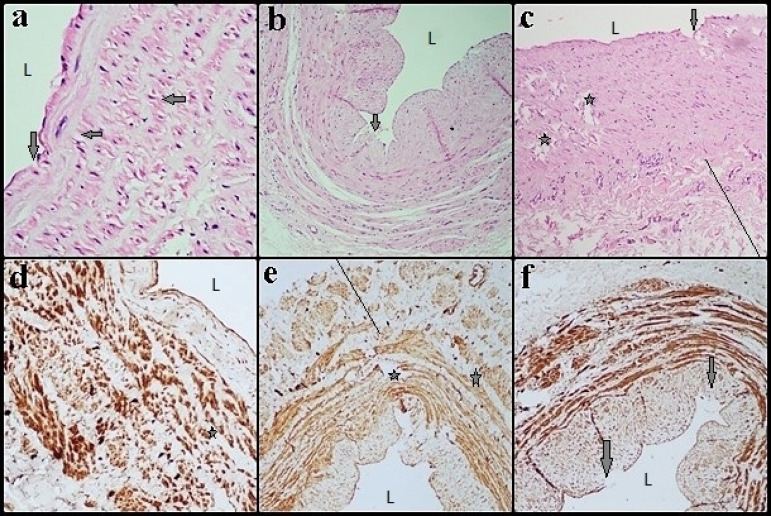
Group II (diabetes mellitus + coronary artery disease): vein sections stained with hematoxylin-eosin (a, b, and c) and parts stained for immunoreactivity with urotensin-II (d, e, and f). (a, b, c, and f) Endothelial areas are visible with lower arrows, internal elastic lamina lost its regular structure, and ruptures occurred in some regions. (d, e, and f) The vascular smooth muscle cells in the tunica media layer could not maintain its normal structure, there were changes in cell morphology and localization in many areas, and there were significant separations in the layer. Left arrows point to foam cells. Star=tunica media. L=lumen. Scale bar=50 µm.